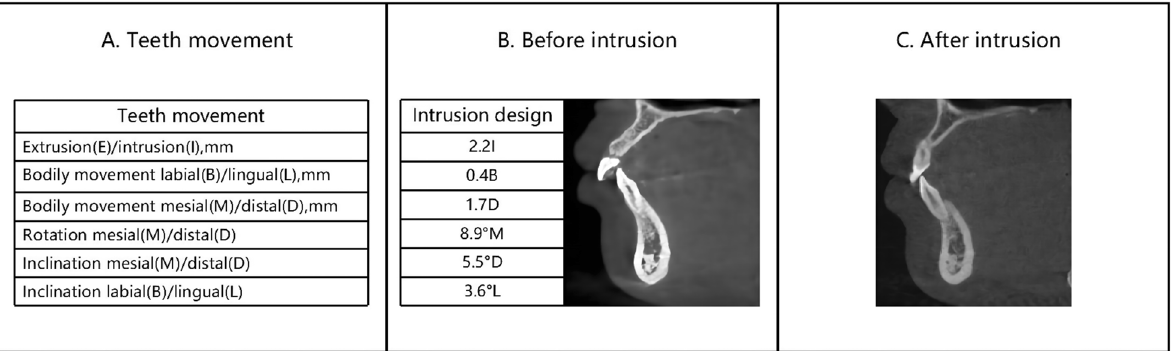
Fig. 1 Changes in the relationship between the root and the alveolar bone during the intrusion of mandibular incisors. Rectangular attachments were set on the labial surface on the lower canines. Four mandibular incisors were simultaneously intruded. The CBCT images of the mandibular left lateral incisor are displayed. A The movement data from top to bottom are extrusion (E) or intrusion (I), labial movement (B) or lingual movement (L), mesial movement (M) or distal movement (D), mesial rotation (M) or distal rotation (D), mesial inclination (M) or distal inclination (D), labial inclination (B) or lingual inclination (L). B Before intrusion, although the alveolar bone on the root labial surface was thin, the root was located in the alveolar bone. The designed direction of intrusion was basically along the tooth axis. C After the intrusion of 2.2 mm, the root moved to the labial side and separated from the alveolar